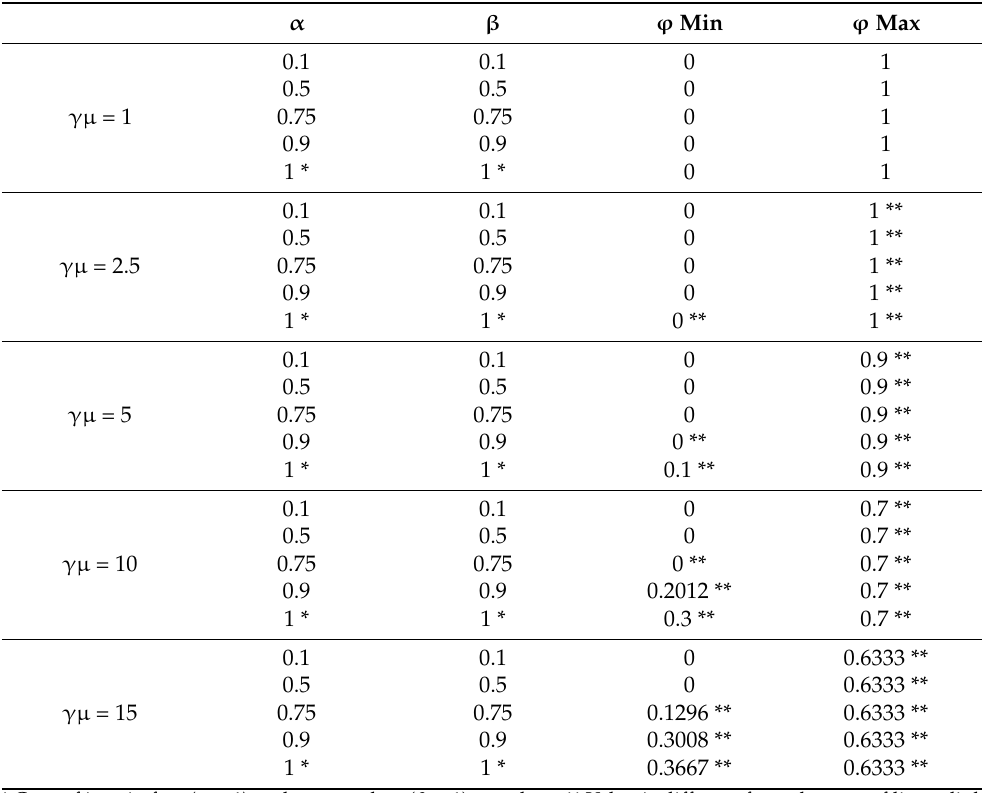
Table 2. Limits of the stability region in terms of ϕ for selected values of γµ , α and β in the case of fourth-power link cost functions. α β ϕ Min ϕ Max